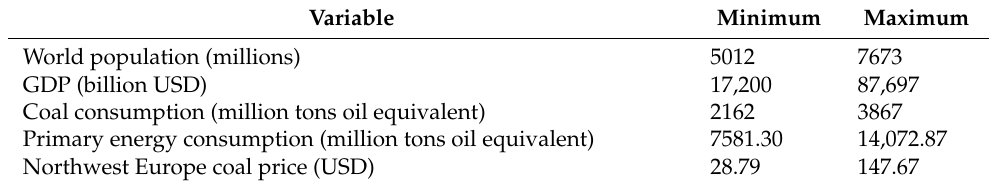
Table 1. Minimum and maximum values of research variables for normalization.